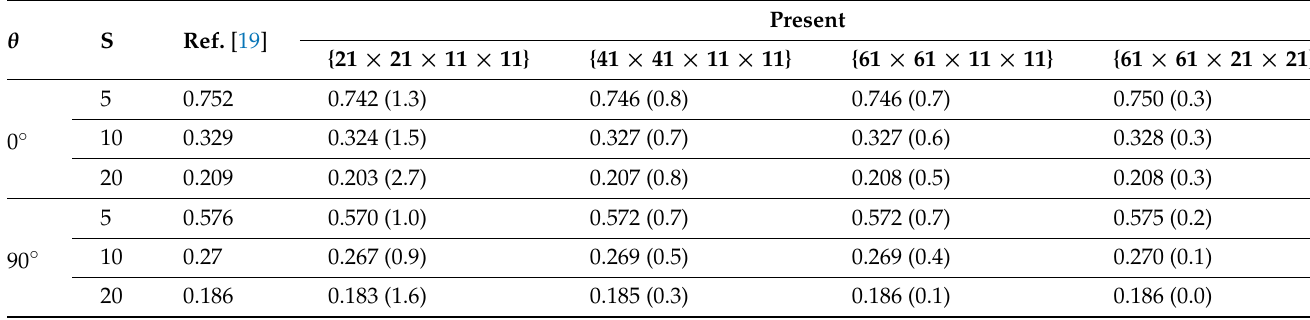
Table 6. The vertical dimensionless displacement, ¯ u z , for material parameter p = 0, for Example 2, for different thickness ratios, S , obtained using different grid